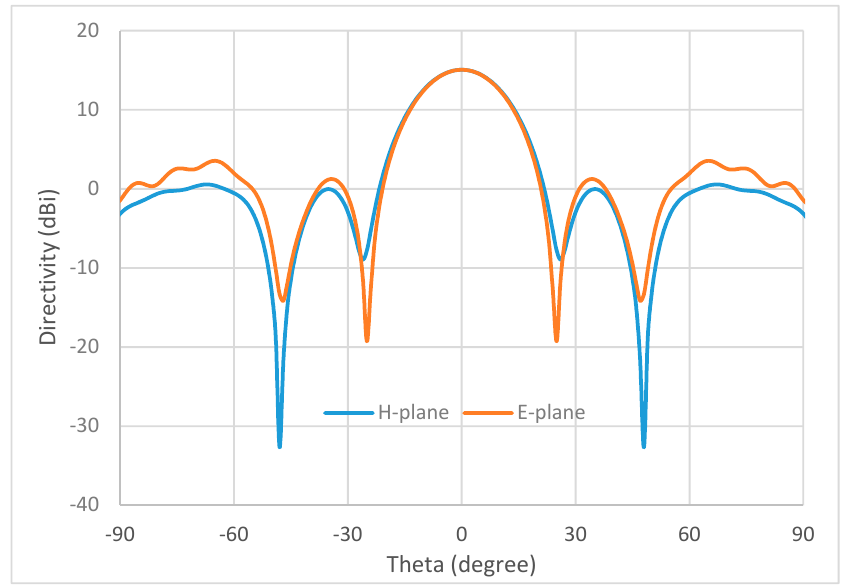
Figure 7. Simulated far-field radiation patterns of the ceramic GRIN lens at 26 GHz.